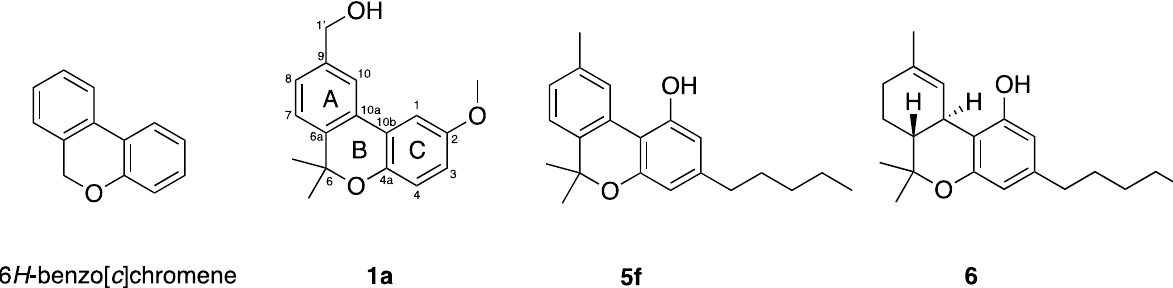
Figure 1. The 6 H -benzo[ c ]chromene scaffold studied here ( left ), and structures of pulchrol ( 1a ), cannabinol ( 5f ) and ∆ 9 -tetrahydrocannabinol ( 6